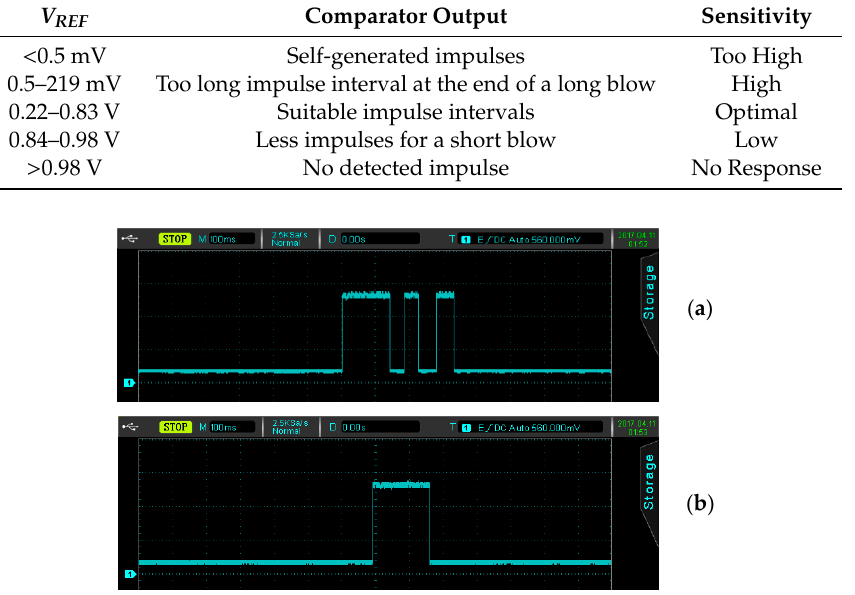
Figure 12. The pulse width output at ( a ) V REF (reference voltage) = 114 mV, and ( b ) V REF = 0.56 V.